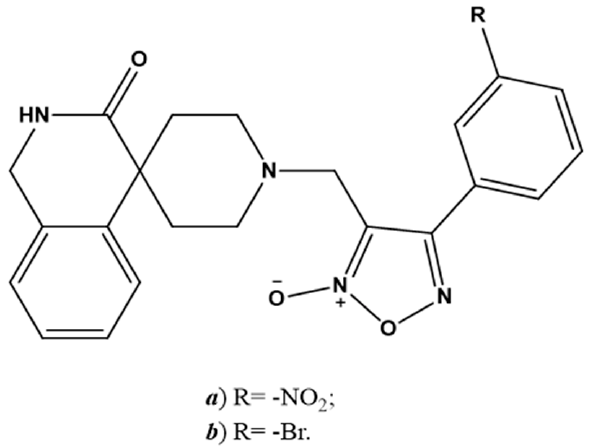
Figure 4. Chemical structure of NO-releasing inhibitors of SARS-CoV-2 proteases. ( a , b ) 4-phenyl furoxan derivatives.